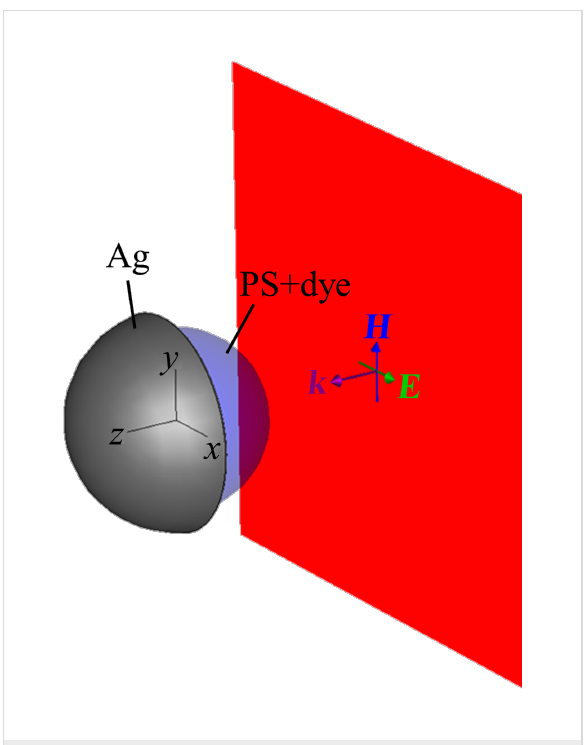
Figure 1: Geometry of the sphere and the illuminating plane wave. The k -vector of the plane wave is defined by ( θ , φ ), in which θ denotes the angle between the k -vector and z axis and φ is the polar angle counted from the x-axis. The shown geometry hence depicts the (0,0)